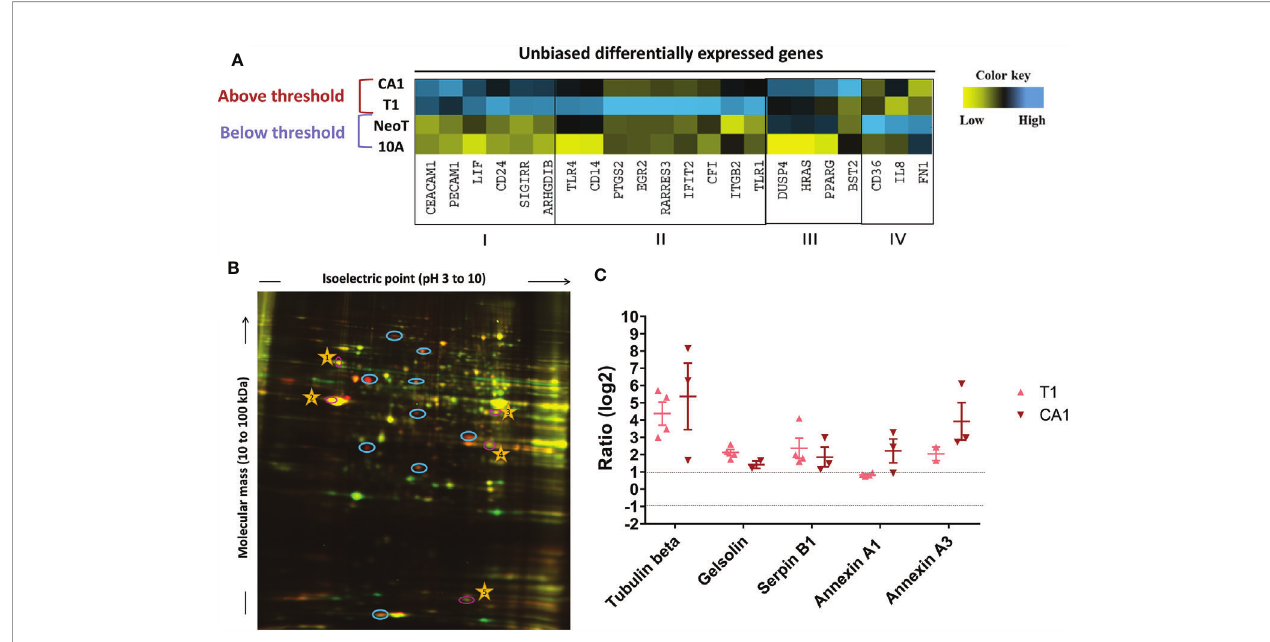
FIGURE 4 | Unbiased identi fi cation of genes and proteins associated with the macrophage activation threshold. (A) Heatmap representation of expression of genes with a fold increase greater than 5 over MCF10A (10A). The color key was provided by the software and shows an expression gradient from low (log2 FC < – 1) to high (log2 FC>1). I, genes upregulated in MCFT1 (T1) and MCFCA1 (CA1); II, genes upregulated in MCFT1(T1) only; III, genes upregulated in MCFCA1 (CA1) only; IV, genes upregulated in MCFNeoT (NeoT) only. (B) Differentially expressed proteins between MCF10A labeled with Cy3-NHS (green) and MCFT1 labeled with Cy5-NHS (red); labeled proteins were mixed and resolved on 2D-DIGE as described in Materials and Methods. Shared proteins migrate identically and appear as yellow spots. Blue circles mark spots unique to MCFT1 that were picked for sequencing. Numbered yellow stars were used in the quanti fi cation analysis as guiding spots. (C) Changes in expression of 2D-DIGE-identi fi ed proteins in MCFT1 and MCFCA1 relative to MCF10A. Results are presented as mean values ± SEM of 4 technical